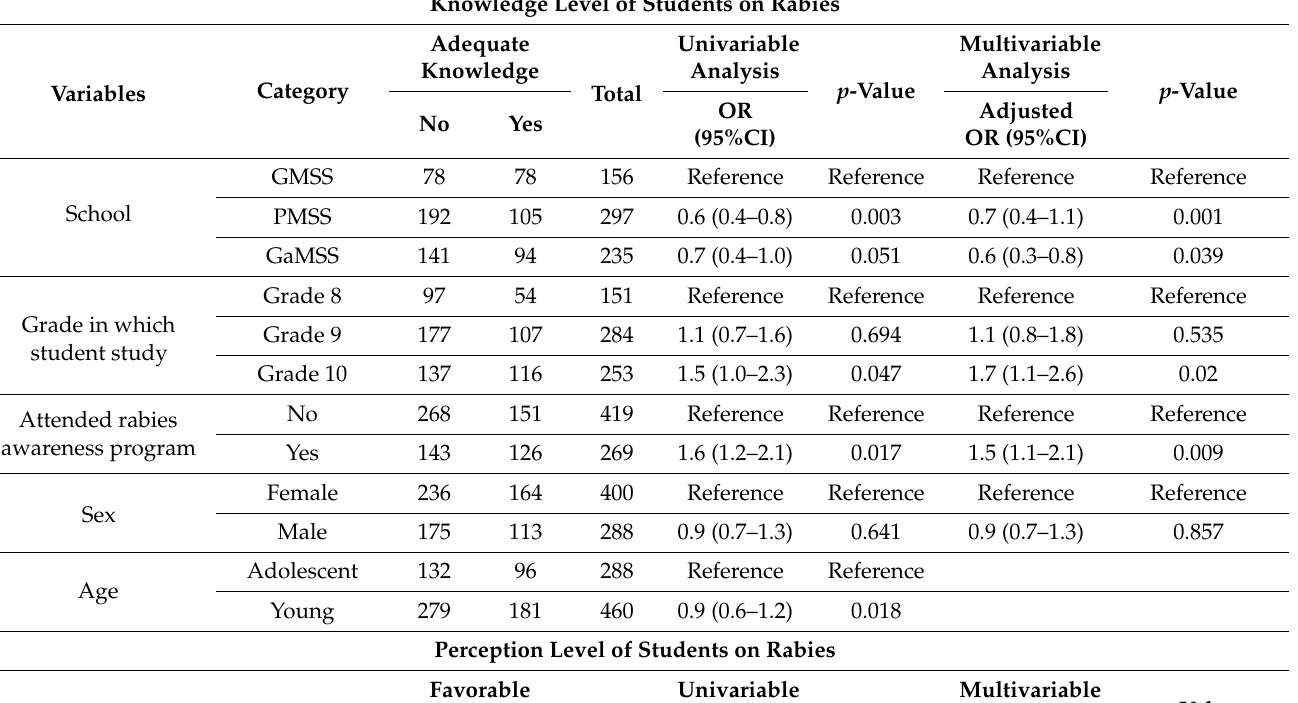
Table 5. Logistic regression model showing the variables associated with the knowledge and perception level of the students on rabies ( n =